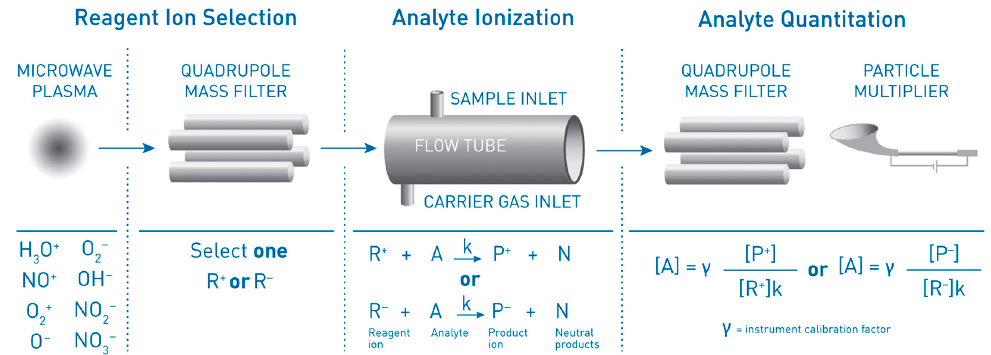
Figure 1. A schematic illustration of the SIFT-MS technique, showing the three zones in this continuous-analysis approach. Used with permission of Syft Technologies.